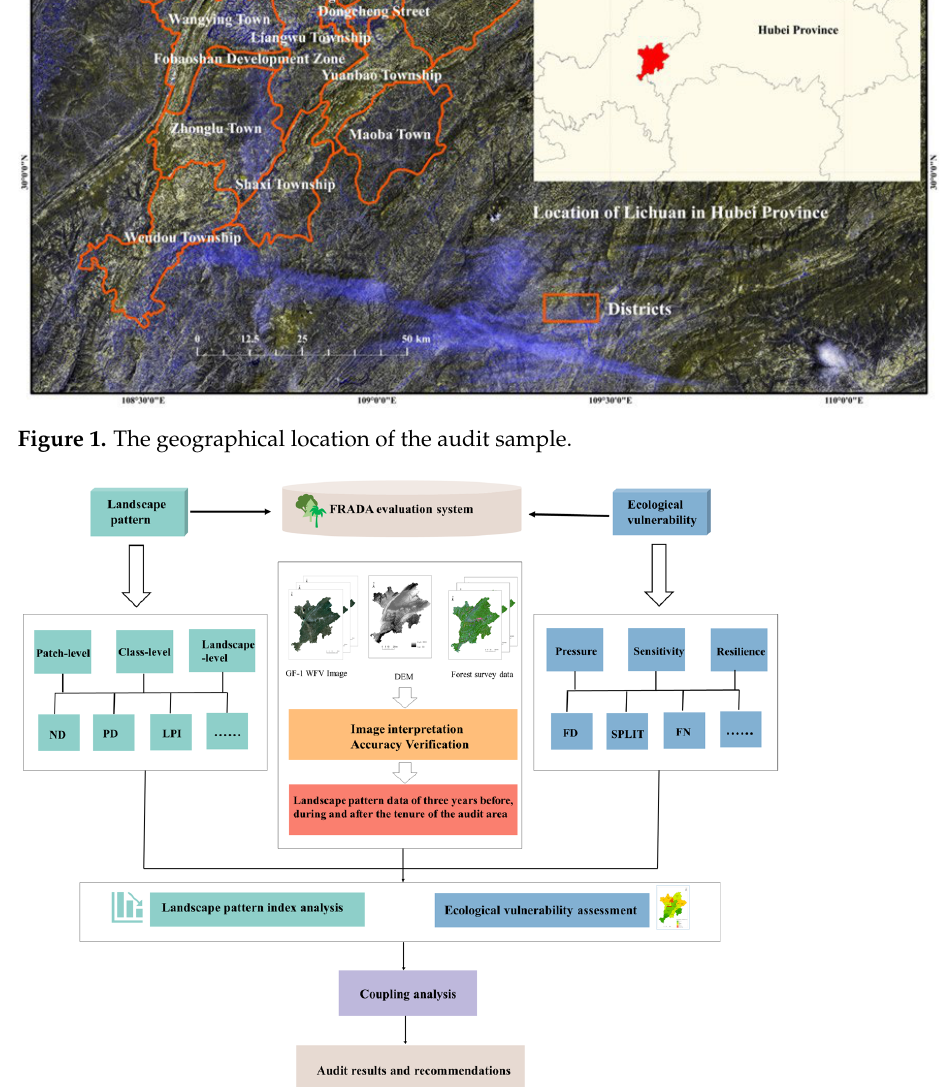
Figure 2. Research Framework.